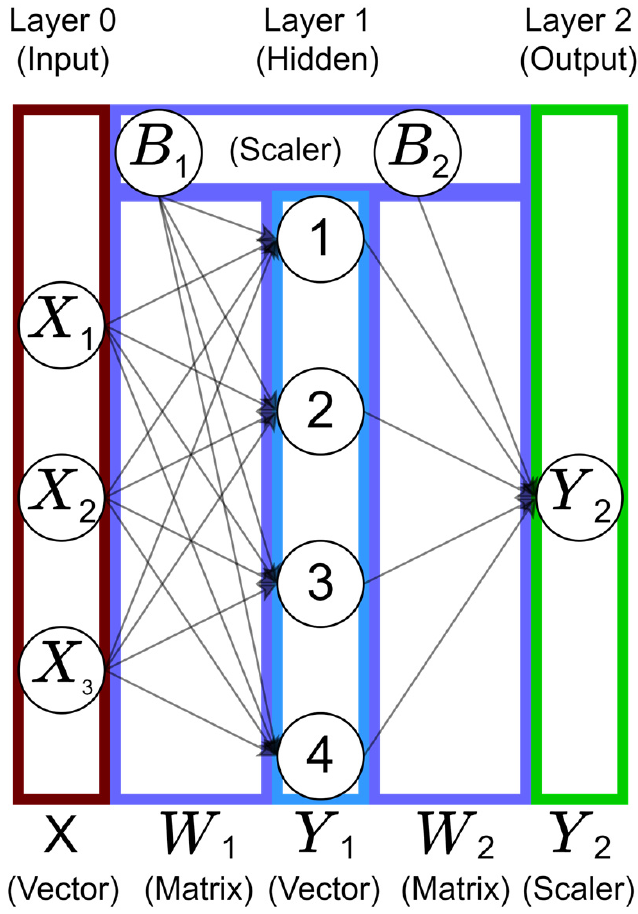
Figure 3. Representation of a neural network containing three inputs and a single output. For the multiphysics design optimization of the MEMS accelerometer, we have cre- ated a deep neural network that is composed of 4 hidden layers such that each layer has a certain number of perceptrons along with their corresponding activation function for that layer. The number of layers and the number of perceptrons are set empirically. The selection of an activation function depends on the problem at hand. For the hid- den layers, we experimented with different activation functions and obtained the best results with ELU in the first hidden layer, and ReLU in the preceding three hidden layers, Equations (5) and (6), respectively. Both ELU and ReLU affect the negative values. ELU uses an exponent operator for its function while ReLU sets the negative value to zero. In Equations (4)–(6), x is the value obtained after the dot product between the input and the weights and the addition of bias to this